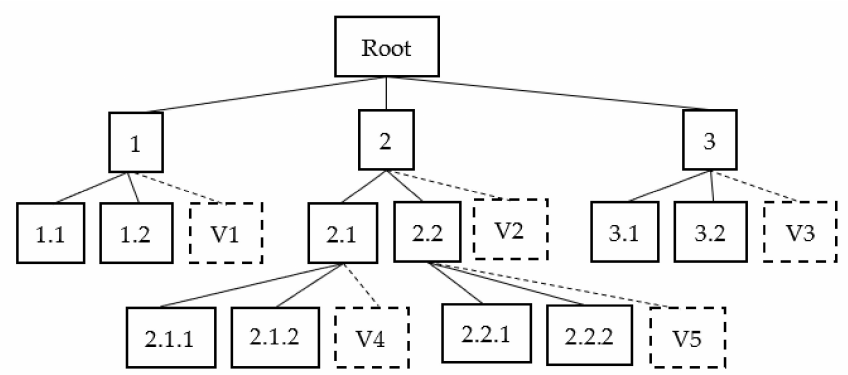
Figure 3. Hierarchical classification using virtual